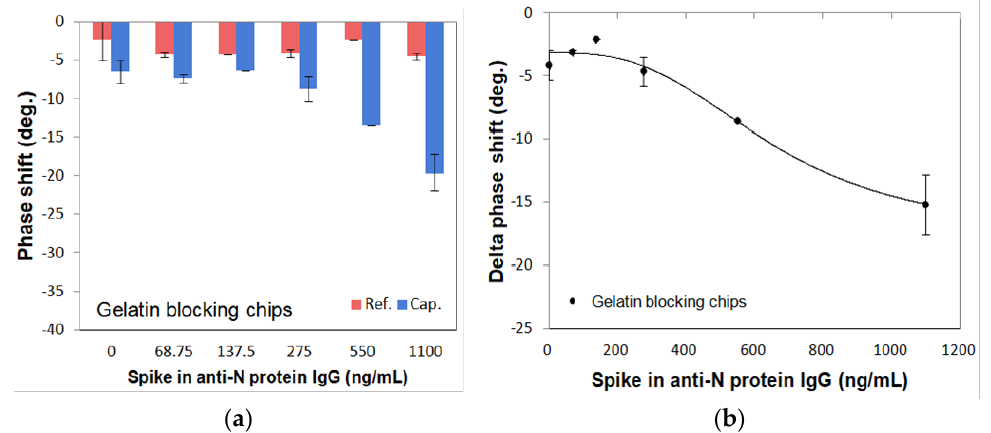
Figure 5. Phase shifts of gelatin blocking SH-SAW biosensor chips in different concentrations of spike-in anti-N IgG samples. ( a ) Phase shifts of reference channel and capture channel; ( b ) delta phase shifts between reference and capture channels.